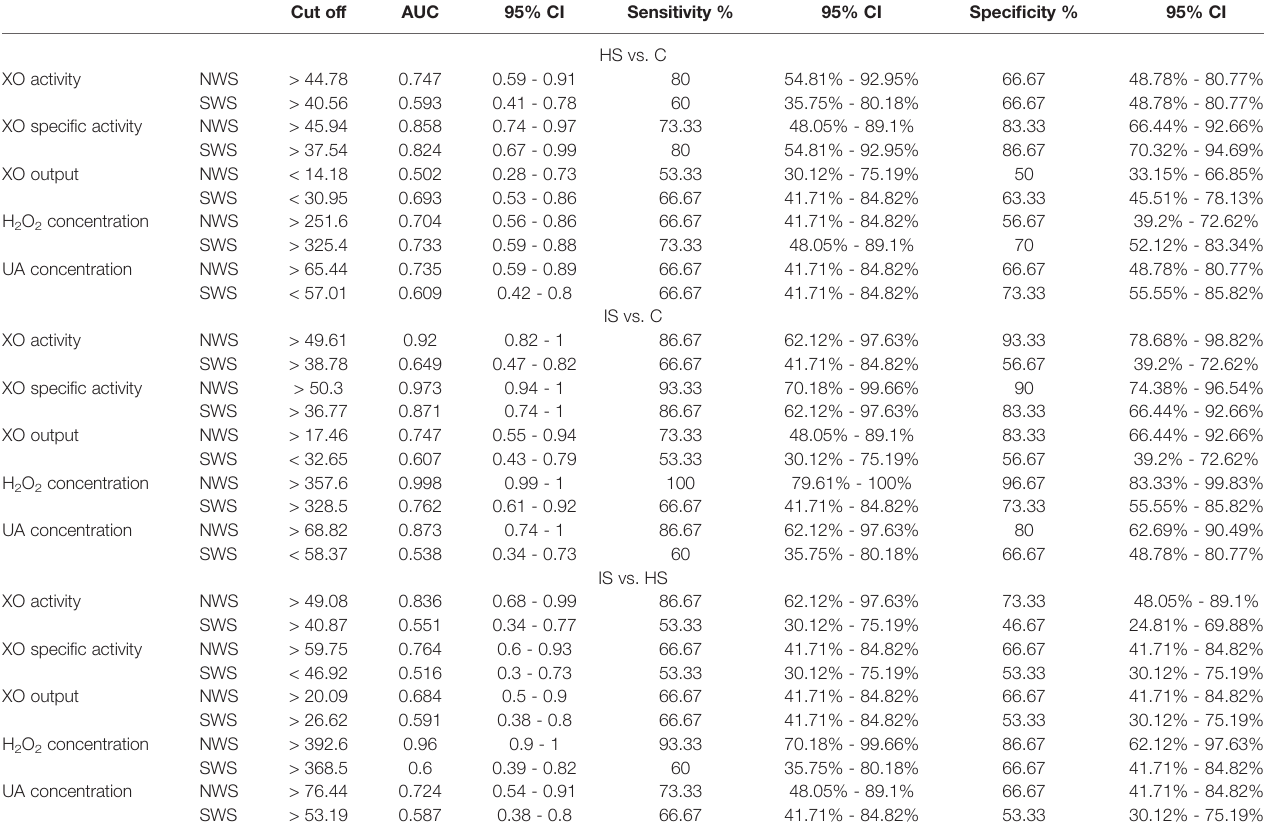
TABLE 6 | ROC analysis of salivary ischemia